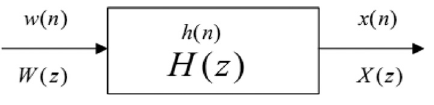
Fig. 1. The spectrum of burst signal and noise signal.